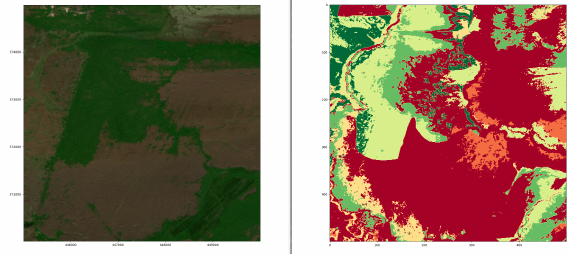
Figure 3. True color map of the selected area and soil erosion prediction result from